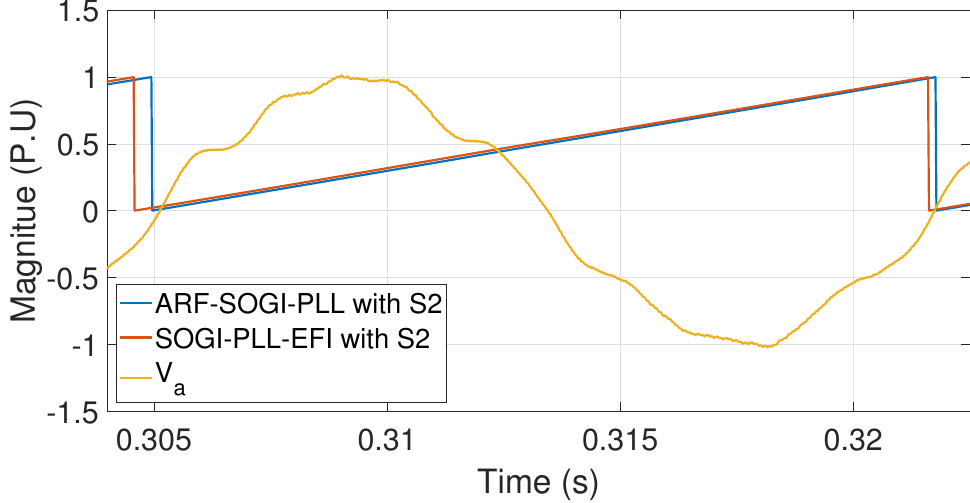
Figure 22. ω t in the final cycle in the synchronization of the ARF-SOGI-PLL.